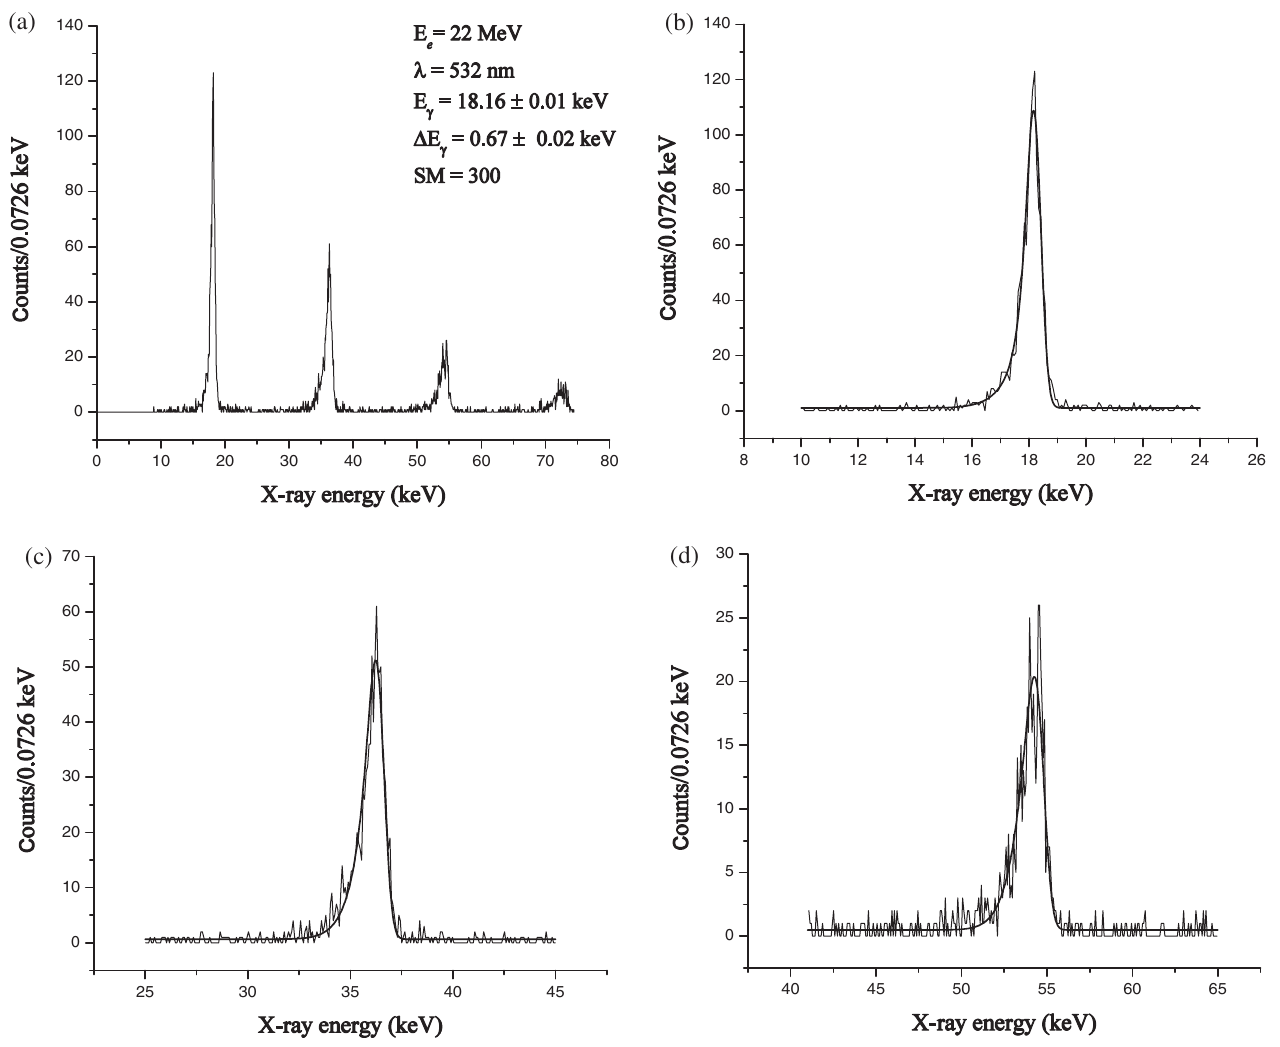
FIG. 9. (a) LCS spectrum taken during a different run at an electron pulse charge equal to 0.9 nC. A 50 : 8 (cid:8) m kapton window was place in lieu of the 50 : 8 (cid:8) m SS window. Several pileup peaks are visible due to the low x-ray absorption of kapton. (b) Fit to the LCS primary peak. (c) First pileup peak together with convolution of fit to the primary LCS peak with itself. (d) Second pileup peak together with double convolution of the fit to the primary LCS peak with